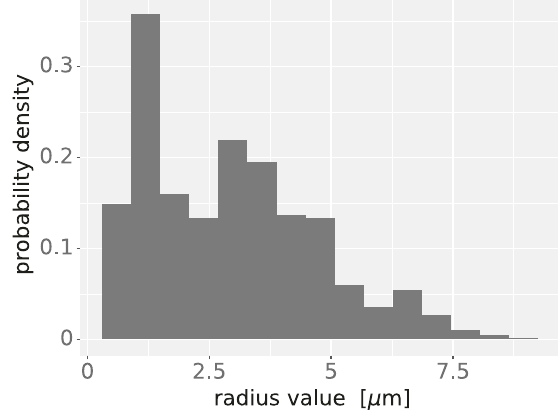
Fig. 3 Multimodality of the radii distribution. Histogram of the values r CT ð u Þ ; ¼ ; r CT ð u Þ of the radius functions for some fi xed 1 n direction u 2 S 2